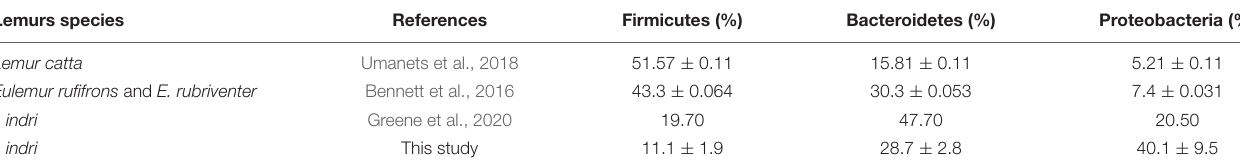
FIGURE 6 | Linear discriminant analysis effect size plots of the biomarkers taxa for the categories family group (A) and sex (B) . TABLE 2 | Percentage of the three top bacterial phyla found in this study and other studies. Lemurs